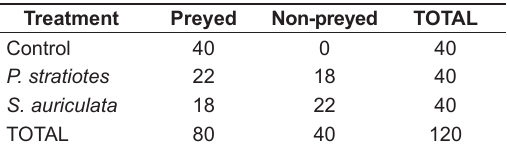
Figure 1. Average predation rate of Chironomidae and Elmidae in the presence of Erythemis nymphs in treatments with P. stratiotes , S. auriculata and without aquatic macrophytes. Table 1. Predation on Elmidae in the differents